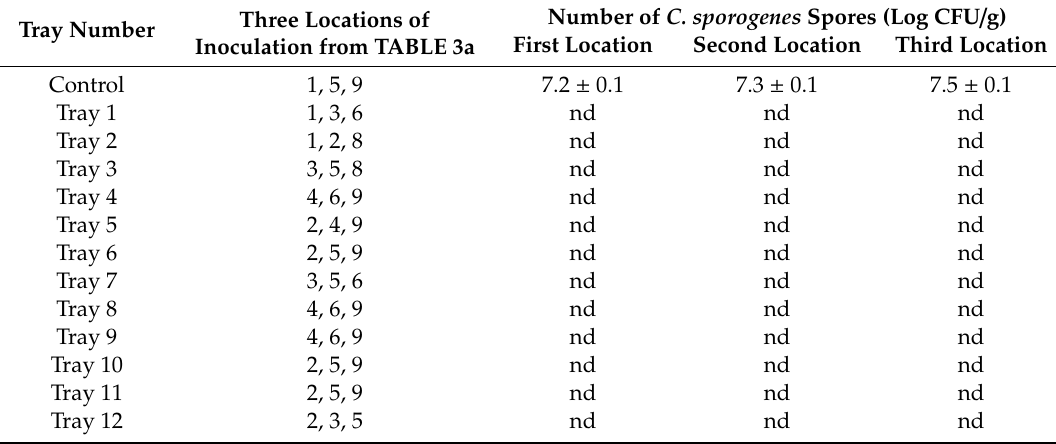
Table 4. Inactivation of C. sporogenes spores at three di ff erent locations on each tray after Coaxially induced microwave pasteurization and sterilization (CiMPAS) (R-121). Three Locations